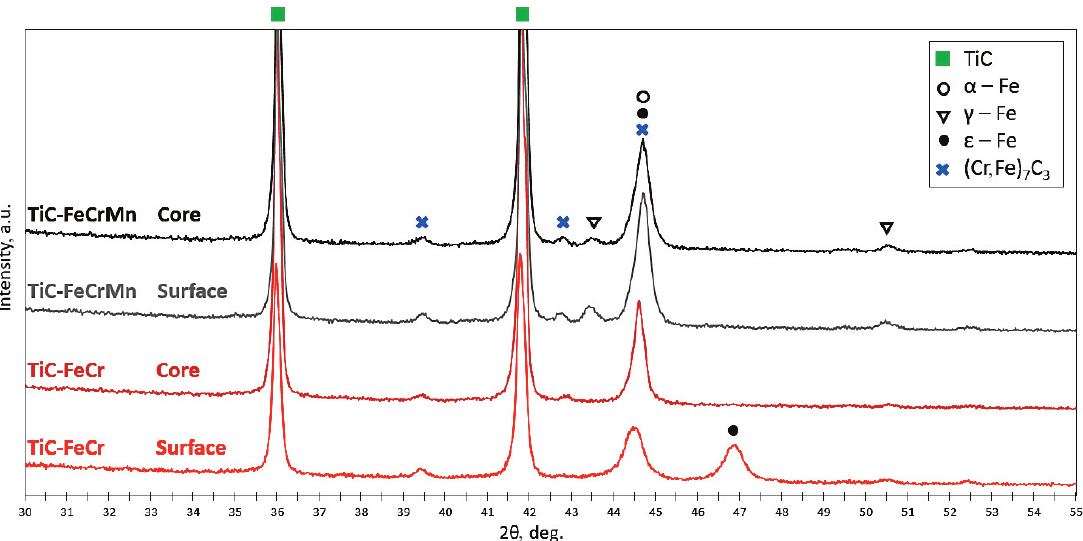
Fig. 5. X-ray diffractograms of the central (core) region and the surface layer of TiC-FeCr and TiC-FeCrMn cermets sintered in Mn-rich